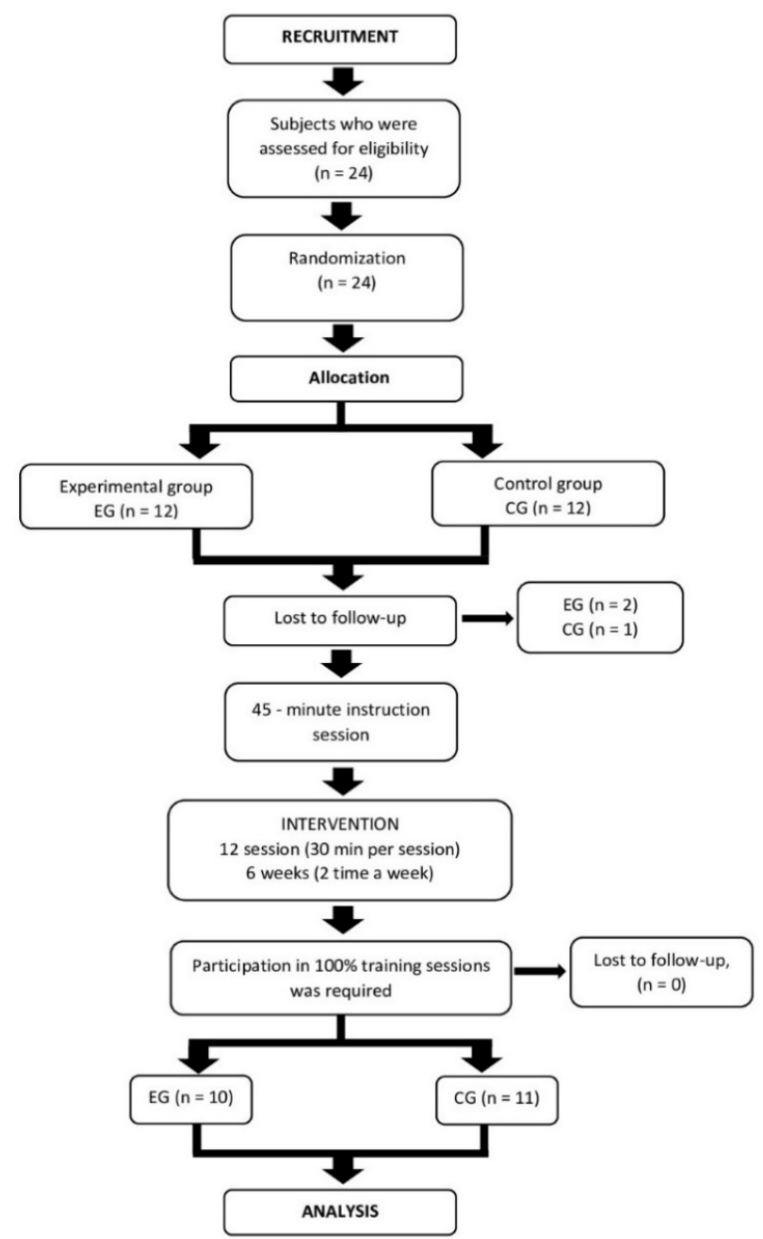
Figure 1. Flowchart of the study participants.